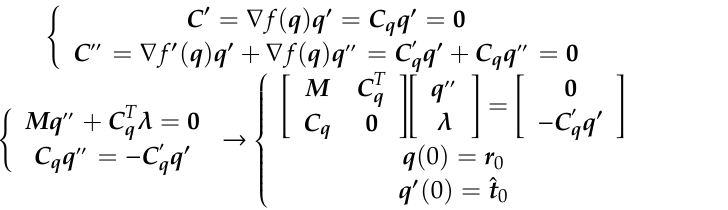
Di ff erentiating the constraint C with respect to the curvilinear coordinate s , the constraint Jacobian (cid:48) C q and its derivative C q are obtained. The geodesic forward dynamics problem written in (23) is a closed non-linear di ff erential algebraic equation and it is solved numerically by marching techniques. Coupling it with the initial conditions r 0 , the attachment point position, and ˆ t 0 , the tangent unit vector parallel to the surface, calculated from the straight-line muscle line action projected on the surface tangent plane, gives the initial direction: the solution q ( s ) is equal to the geodesic c ( s ) .